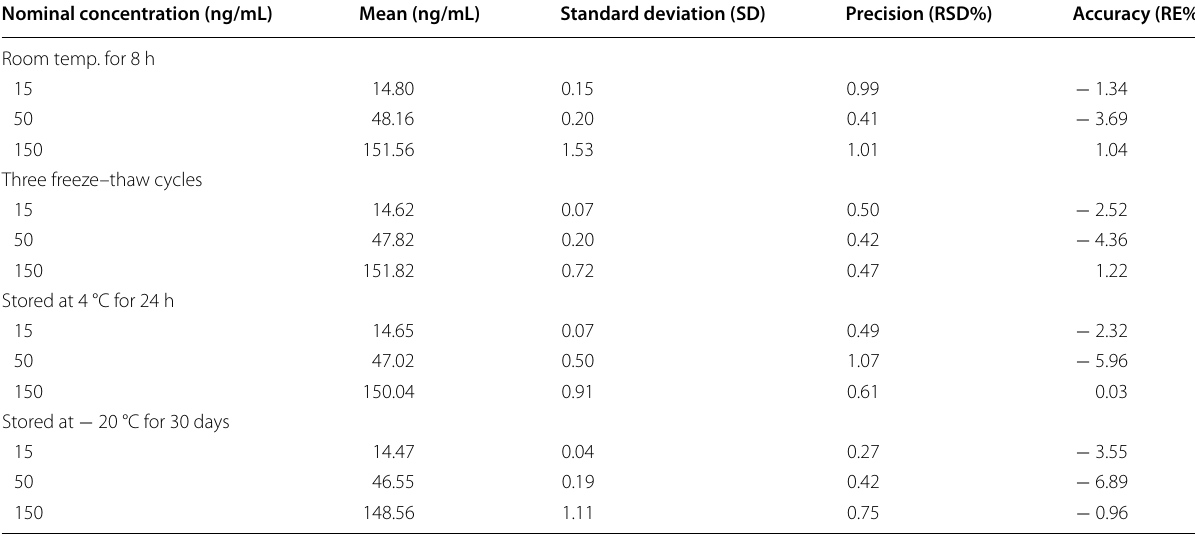
Table 3 MST Stability data in RLMs matrix under different conditions